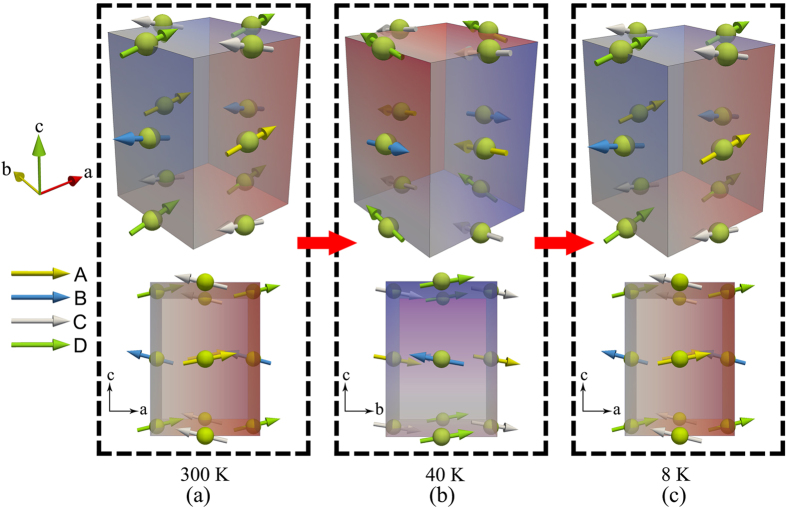
Evolution of magnetic phases for TbFe0.75Mn0.25O3.The upper panels display (a) Γ4(Gx, Ay, Fz) phase at T = 300 K, (b) Γ1(Ax, Gy, Cz) phase at T = 40 K, and (c) Γ4(Gx, Ay, Fz) phase at T = 8 K. The lower panels illustrates the side view of the upper panels, respectively. Arrows of A-D represent four kinds of spin moments of Fe(Mn) ions.